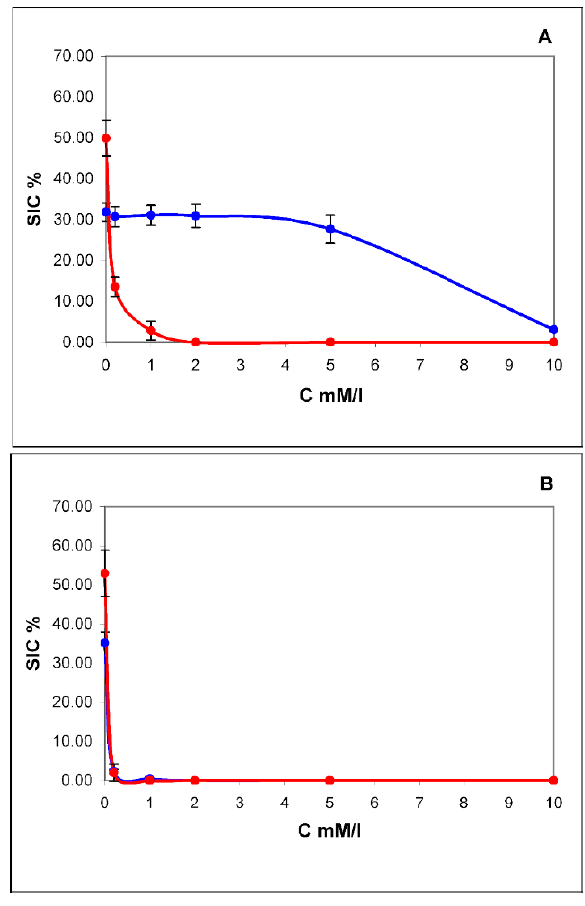
Figure 3. Concentration dependence of lysis of exomeres (blue curve) and exosomes (red curve) by pure Triton X-100 ( A ) and after in a mixture with methylbetacyclodextrin (MβCD) in concentration of 5 mmol ( B ). On the X -axis is the concentration of Triton X-100 in mM/L, on the Y -axis is the contribution to scattering (SIC) in %.